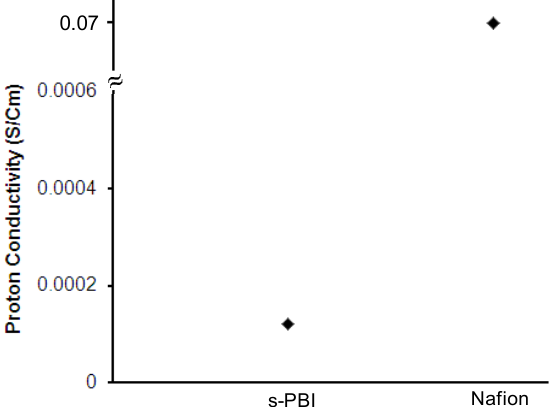
Figure 4. Proton conductivity of s - PBI and Nafion.